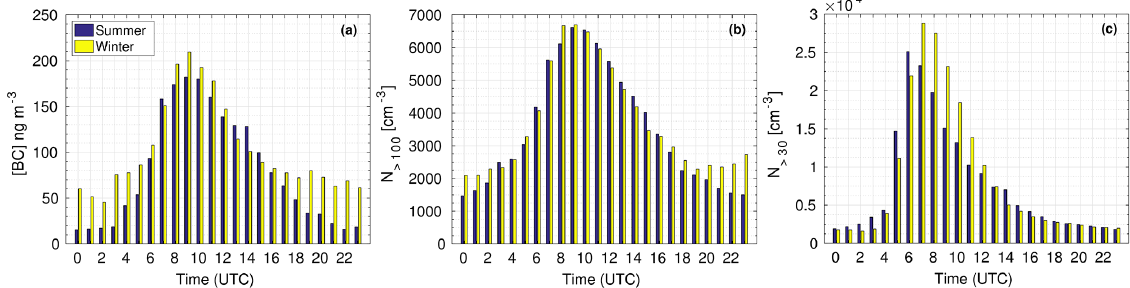
Figure 4. Average diurnal variation during winter and summer of the (a) BC concentration, (b) number concentration of particles with diameters larger than 100nm ( N > 100 ) , and (c) number concentration of particles with diameters smaller than 30nm ( N < 30 ) .